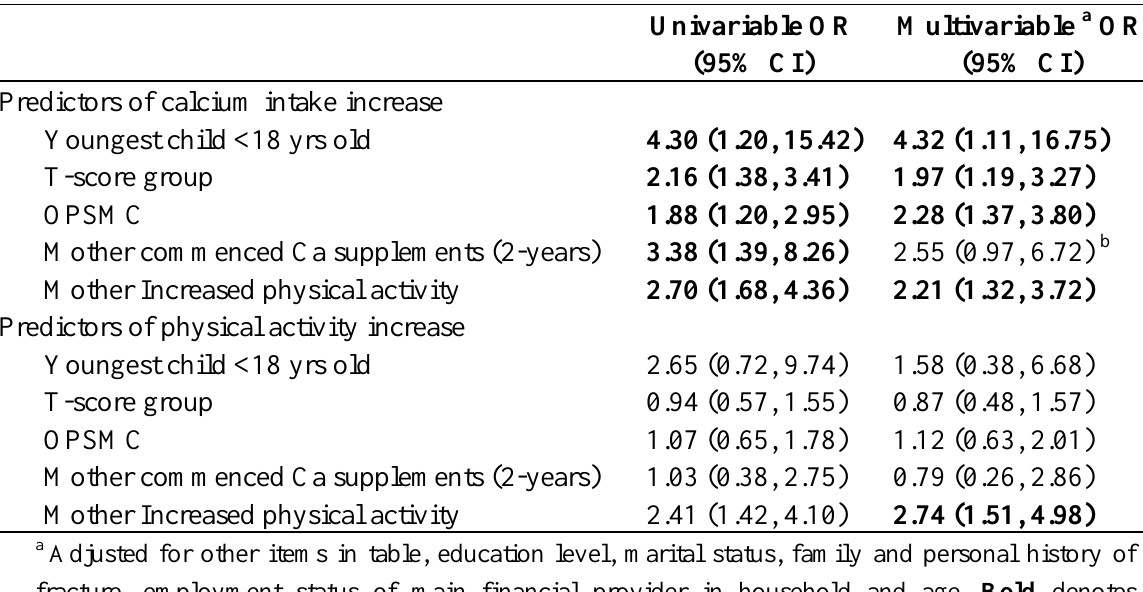
Table 2. Predictors of maternal report of changing children’s calcium intake and physical activity (adapted from Winzenberg 2006